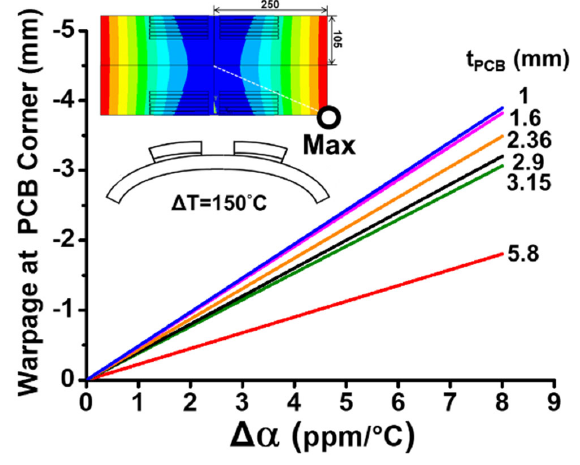
Figure 23. The effects of the thickness of the PCB (t PCB ) and mismatch of CTE ( ∆ α ) on thermally induced warpages at the corner of the PCB for the socket-PCB assembly with 24 sockets from the FEM simulation Δ T= 30 °C − 180 °C = − 150 °C.